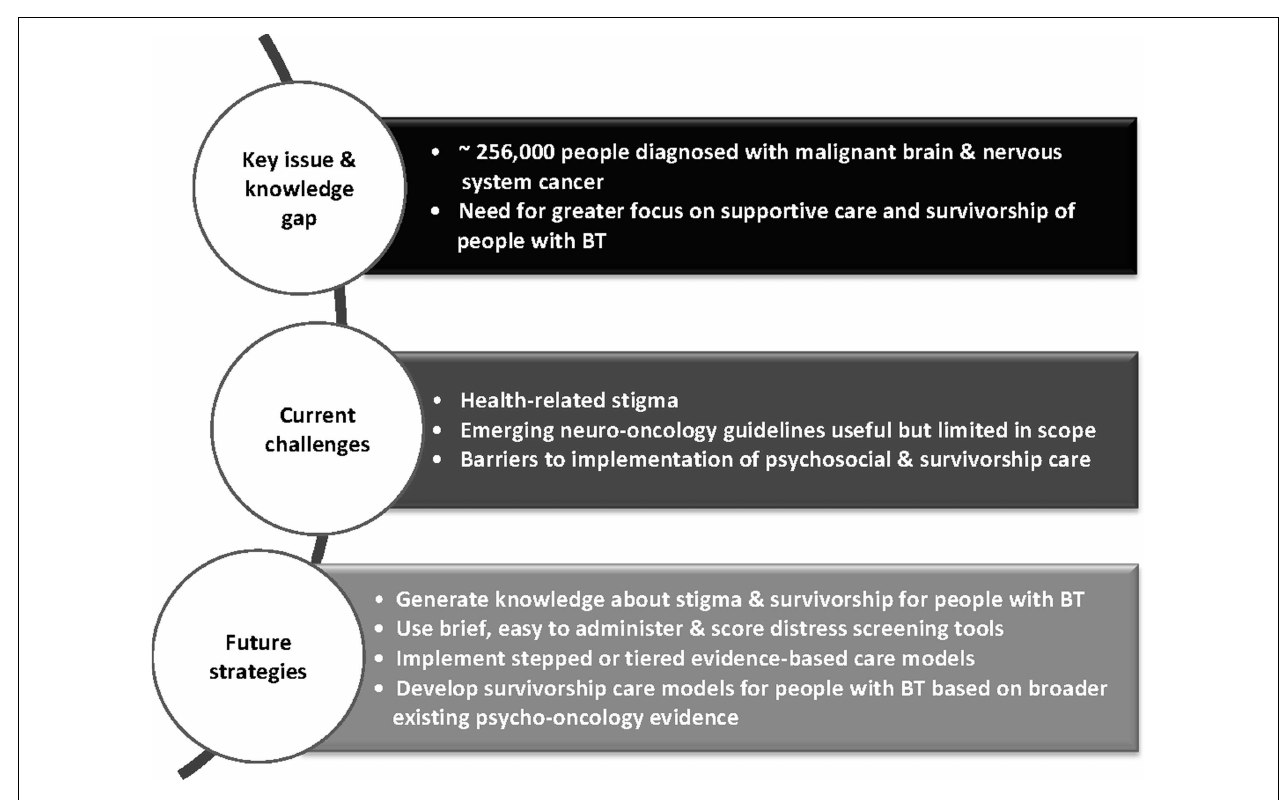
FIGURE 1 | Overview of challenges and strategies for integrating psychosocial care into neuro-oncology